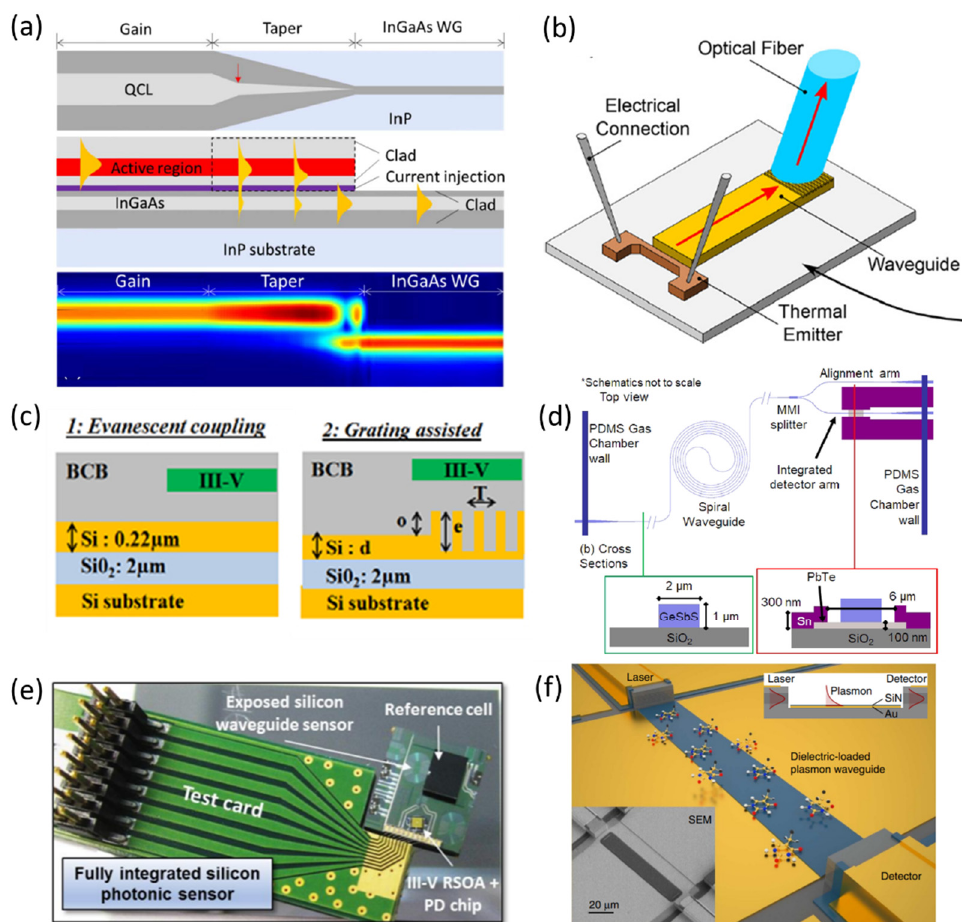
Figure 2. Integration schemes for waveguide-based IR absorption spectroscopy. ( a ) Integrated QCL source with a passive InGaAs waveguide (reproduced from [151] © 2021 Optical Society of America). ( b ) Integration of a waveguide sensor with a MIR thermal emitter (reproduced with permission from [154]). ( c ) Integration of a p-i-n-based GaInAsSb photodetector with a passive waveguide through evanescent and grating-assisted coupling (reproduced from [155] © 2021 Optical Society of America). ( d ) Monolithic integration of a PbTe detector, coupled with a spiral waveguide (reproduced with permission from [156]). ( e ) Prototype of a fully integrated silicon photonic sensor with laser, waveguide, and detector for sensing in the near-infrared (reproduced with permission from [157]). ( f ) Quantum cascade laser and detector, integrated with a dielectric-loaded plasmonic waveguide for sensing in the mid-infrared (copyright © 2021, the author(s) [153]).